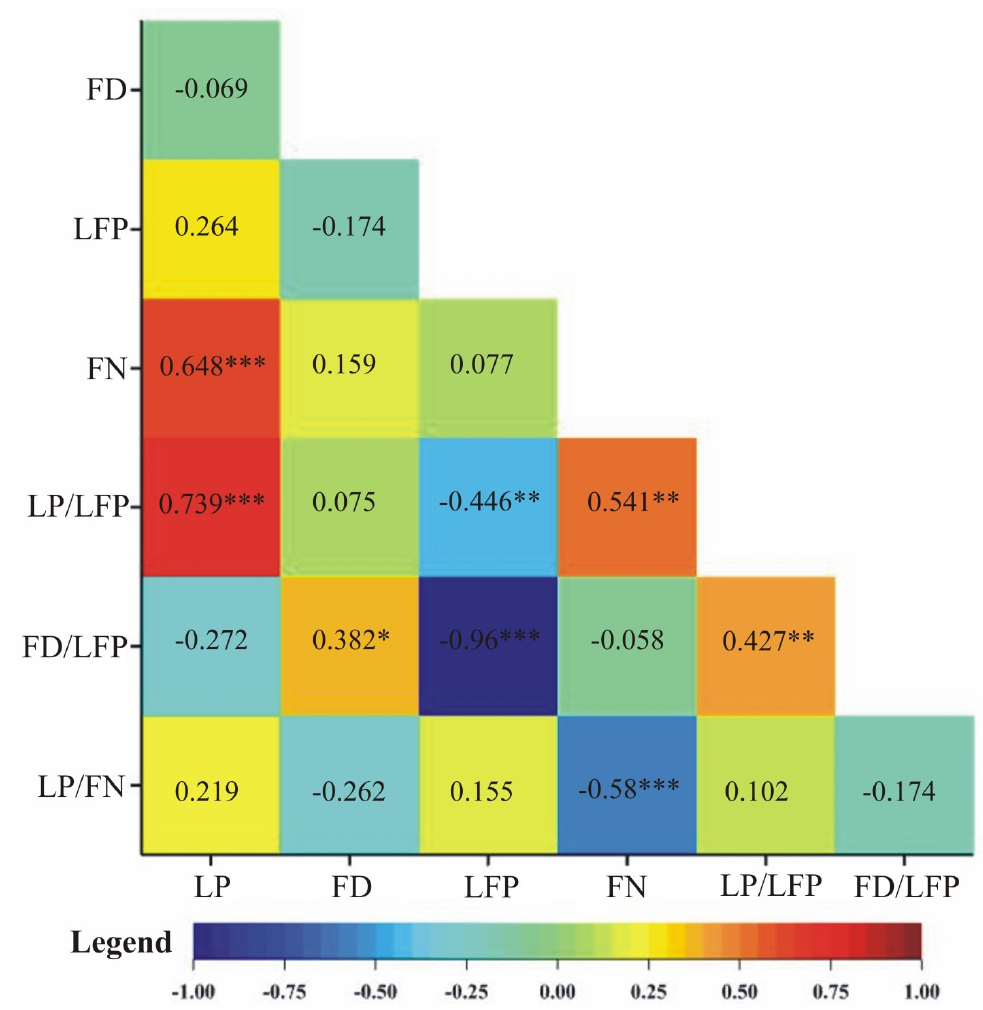
Figure 6. Heatmap for linear Pearson’s correlation coefficients between observed features of P. serotina estimated on the basis of tree means (* p < 0.05; ** p < 0.01; *** p < 0.001). LP—length of peduncle, FD—flower diameter, LFP—length of flower peduncle, FN—flower number.